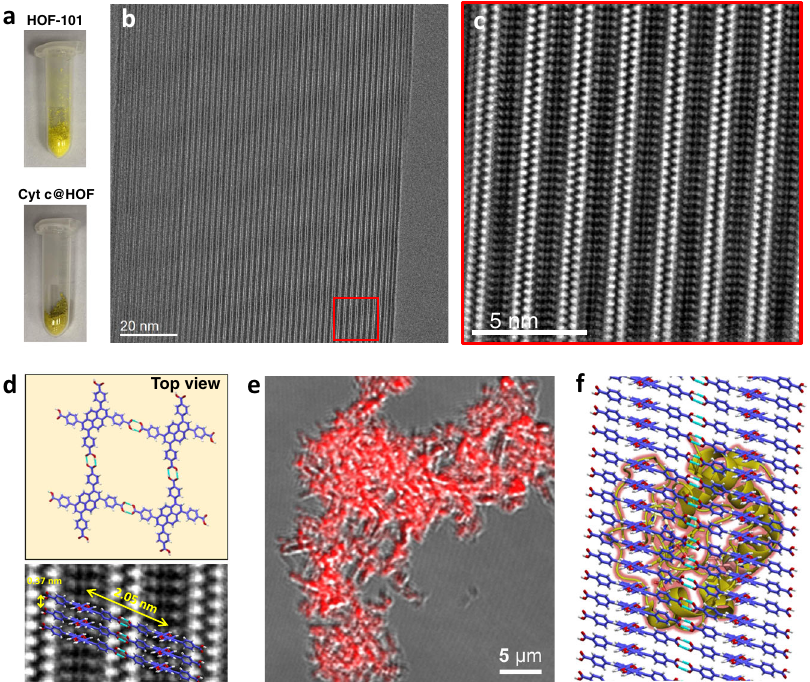
d Detailed structural analysis of the Cyt c@HOF-101. e CLSM shows the spatial distribution of Cyt c (labelled by red dyes) within the framework, and f the sche- matic presentation of Cyt c@HOF-101. The colors used in HOF-101 are: red for O atom; blue for C atom; white for H